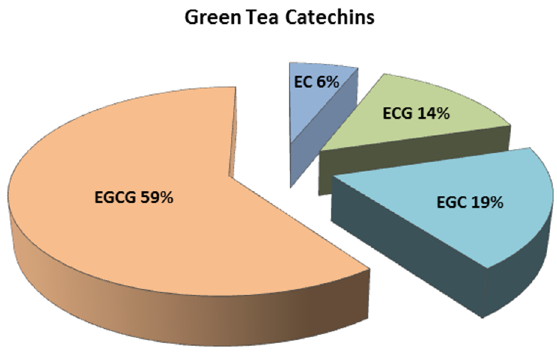
Figure 2. Relative composition of green tea catechins.